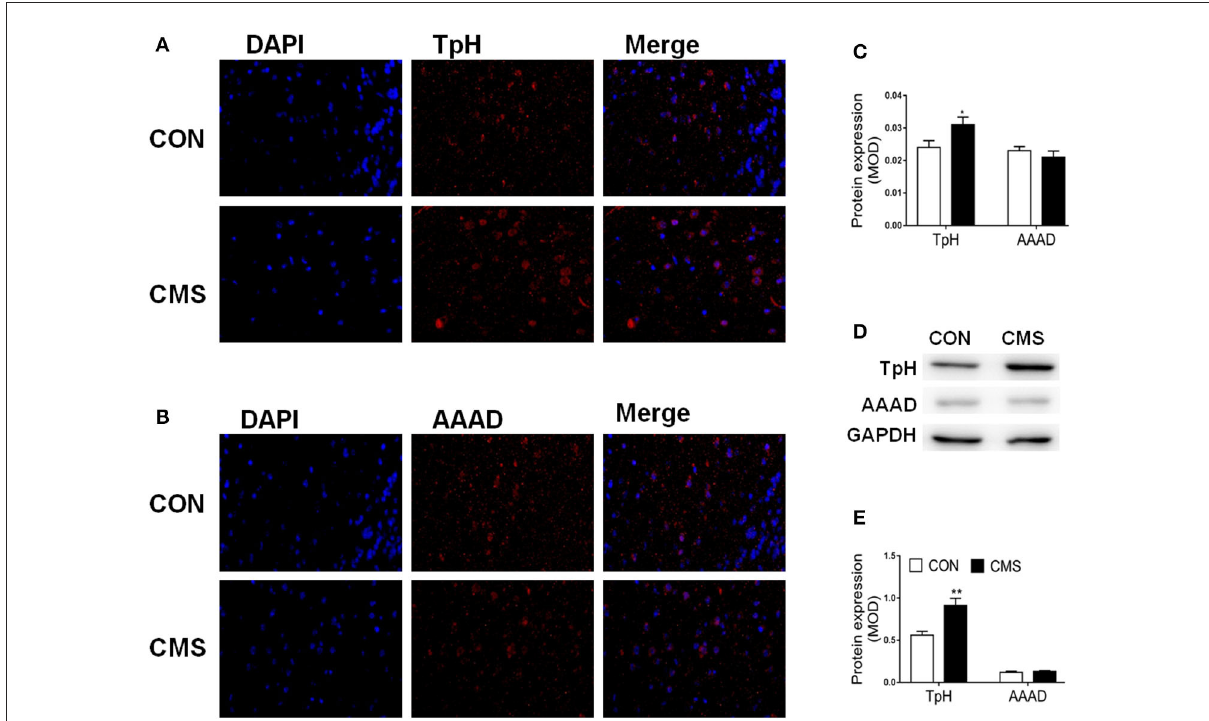
FIGURE4 The protein expression of tryptophan hydroxylase (TpH) and aromatic amino acid decarboxylase (AAAD) in the olfactory bulb of chronic mild stress mice. (A–C) The protein level of TpH and AAAD by immunofluorescence; (D, E) The protein level of TpH and AAAD by Western blot. n =